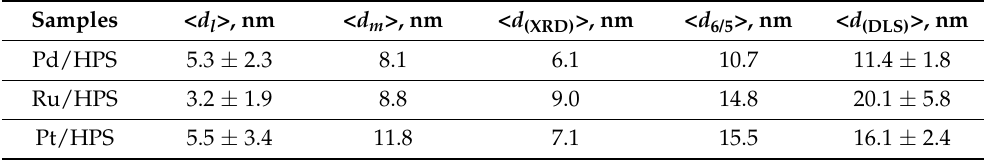
Table 3. TEM and XRD data for noble nanoparticles supported on HPS and DLS data for prepared sols from these